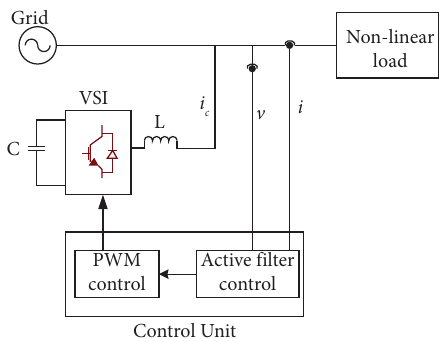
Figure 1: Confguration components of the APF.